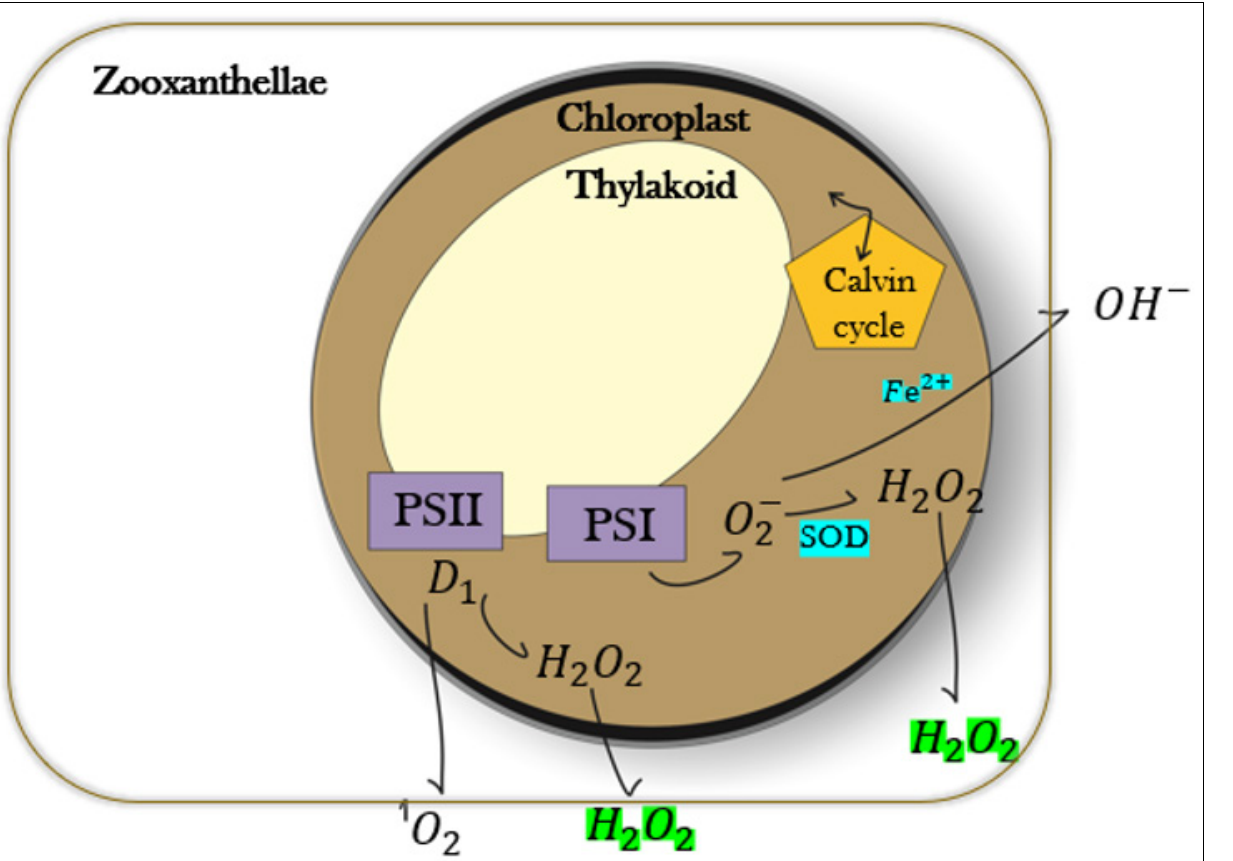
Figure 2: Schematic representation of the oxidative theory of coral bleaching within both the coral host and zooxanthellae endosymbiont, as described by Downs et al. 9 and Weis 25